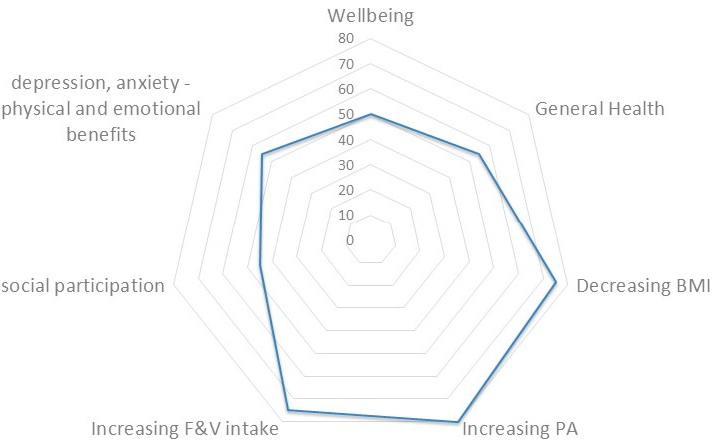
Figure 5. Spider chart providing a graphical representation of the percentage of studies meeting their outcomes subgrouping them for analyzed health dimensions.